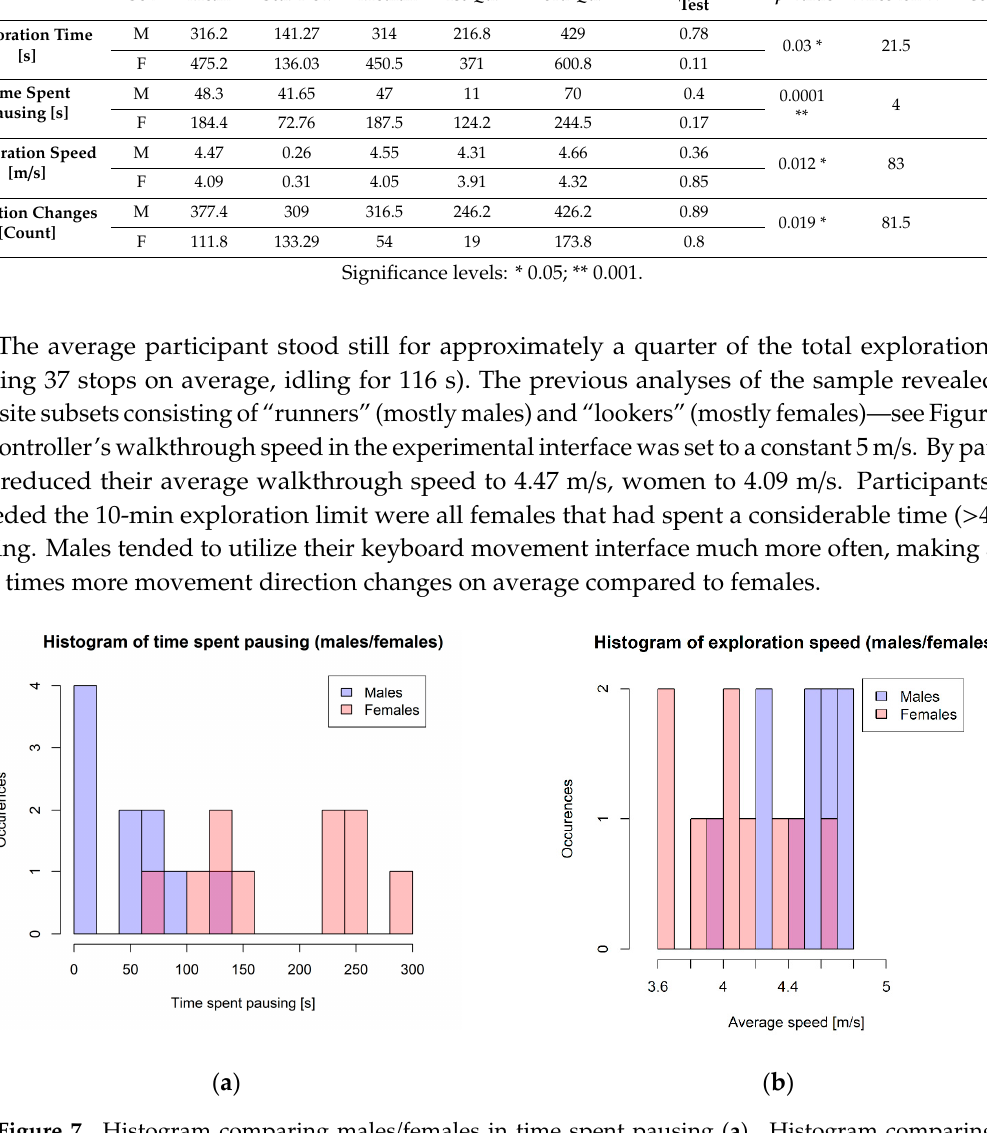
Figure 7. Histogram comparing males / females in time spent pausing ( a ). Histogram comparing males / females in average exploration speed ( b ).